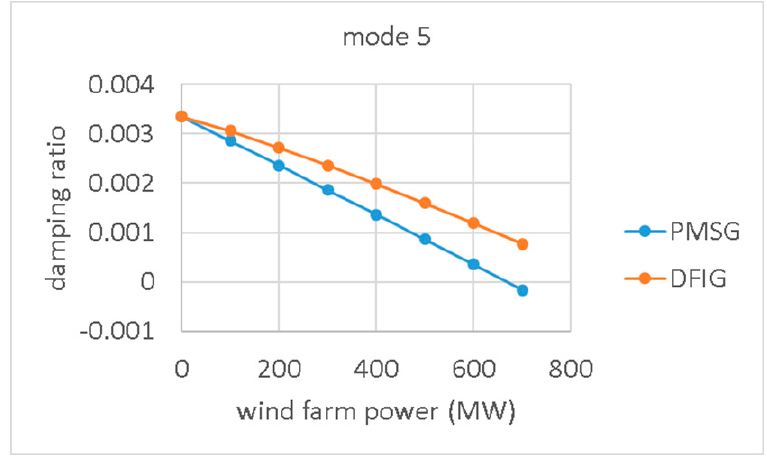
Figure 13. Damping ratios of torsional modes for the integration of the PMSG wind farm.